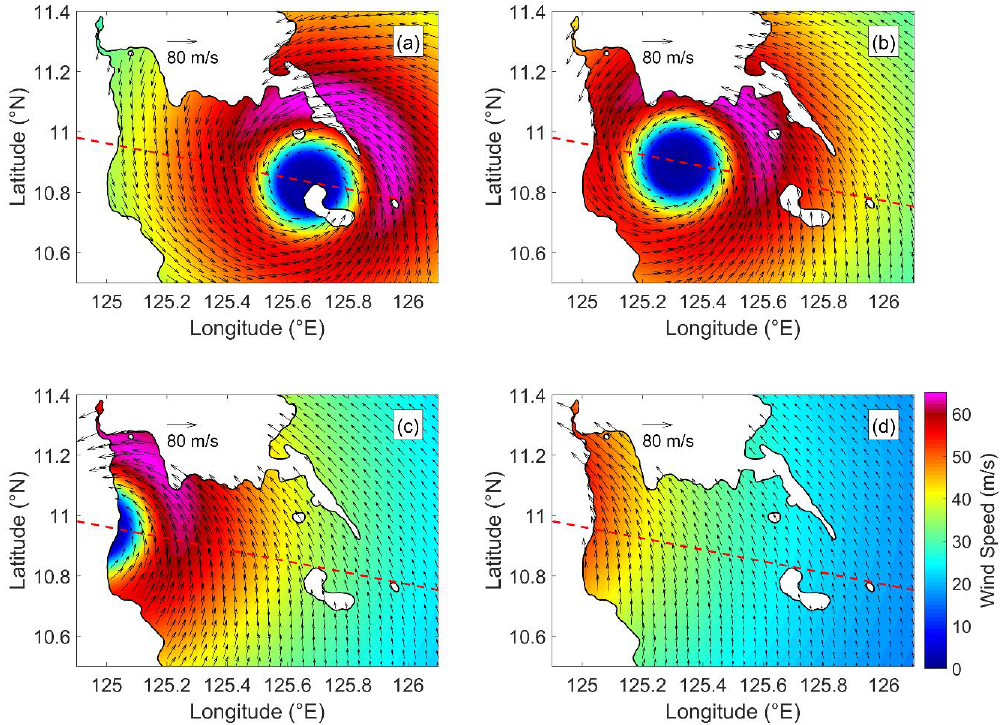
Figure 5. Snapshots of the 10-m winds predicted by HWM at: ( a ) 21:30 UTC 7 November 2013; ( b ) 22:30 UTC 7 November 2013; ( c ) 23:30 UTC 7 November 2013; ( d ) 00:30 UTC 8 November 2013. The dashed red line denotes the JMA best track. The color shading indicates the 10-m wind speed in m / s. The 10-m winds shown in this figure have been interpolated to the grids of the storm surge model. The arrows depict the wind direction per every 15 grids over the domain. These snapshots have been zoomed in from the original computational domain.